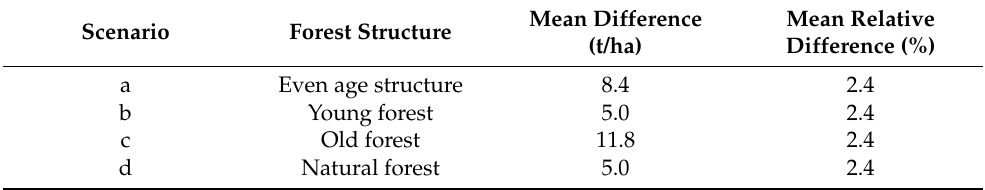
Table 5. Landscape-level comparison between CBM and PSP computation methods: CBM-PSP difference in total landscape-level carbon estimation over 150 years, in a 150-ha hypothetical forest with (a) even amounts of the five forest communities across all ages and (b), (c), (d) varying levels of stand age